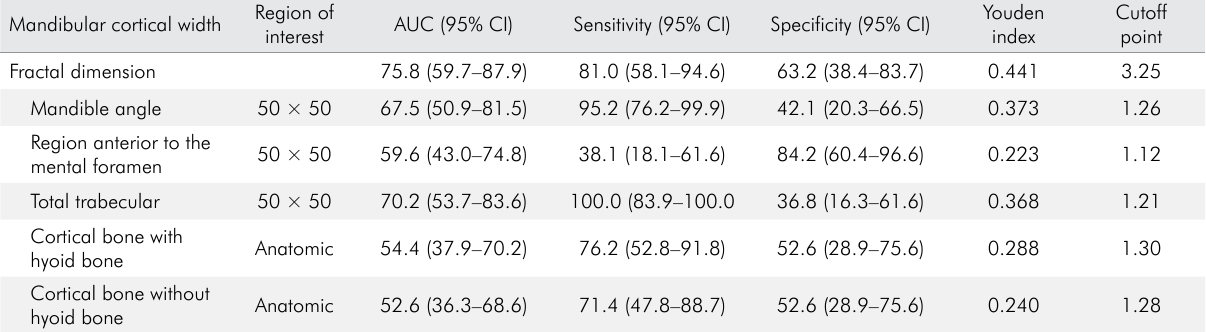
Table 1. Evaluation of area under the curve (AUC), sensitivity, specificity, Youden index, and cutoff point of the radiomorphometric indices in digital panoramic radiography